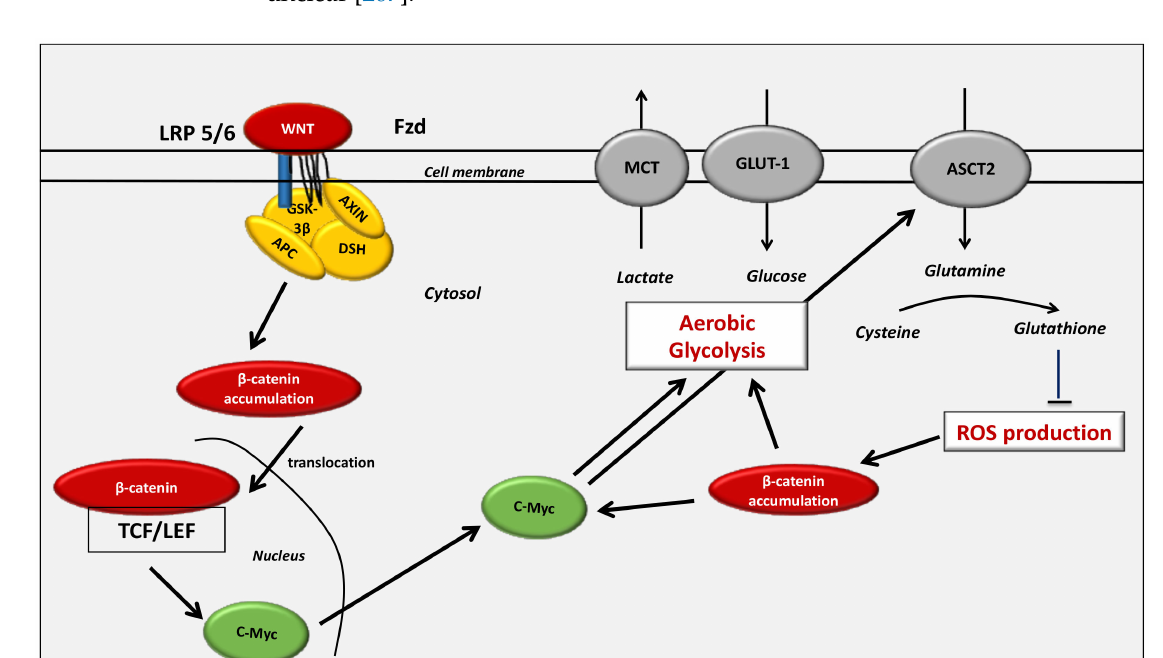
Figure 5. Interplay between the WNT/ β -catenin pathway, aerobic glycolysis and glutaminolysis. c-Myc has been observed to play a role in the activation of genes involved in glutamine metabolism, including the glutamine transporter ASCT2 (or SLC1A1) and glutaminase [271]. Moreover, β -catenin can control glutamine metabolism and glutaminolysis by directly acting on c-Myc [272]. Aerobic glycolysis, directly modulated by the WNT/ β -catenin pathway stimulates the different receptors of the glycose pathway and activates the MCT (monocarboxylate transporters) to translocate the lactate over the cell. The process of glutaminolysis, indirectly activated by the aerobic glycolysis and β -catenin signaling leads to the down-production of ROS, which in turn activates the β -catenin. Abbreviations: MCT: monocarboxylate transporter, Glut-1: glucose transporter 1, ASCT2: glutamine transporter 2, ROS: reactive oxygen